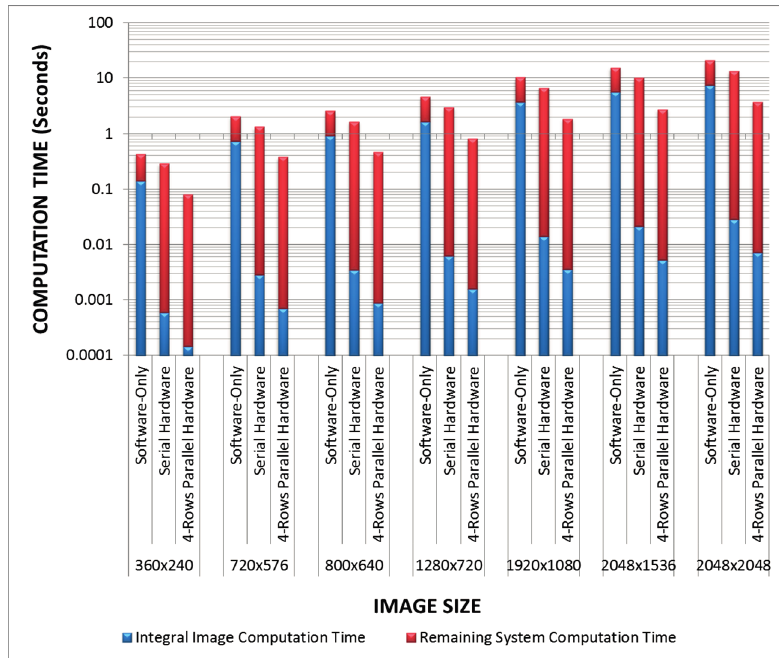
Figure 17. Comparative timing analysis (in logarithmic scale) of the three prototype implementations of the fast adaptive binarization algorithm [32] on a Xilinx Virtex-6 FPGA for some common image sizes.